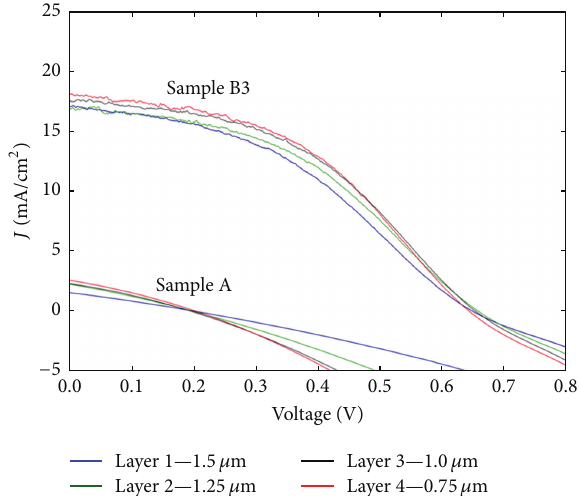
Figure 3: The Raman spectra of samples A and B3 before and after the CdCl 2 treatment.